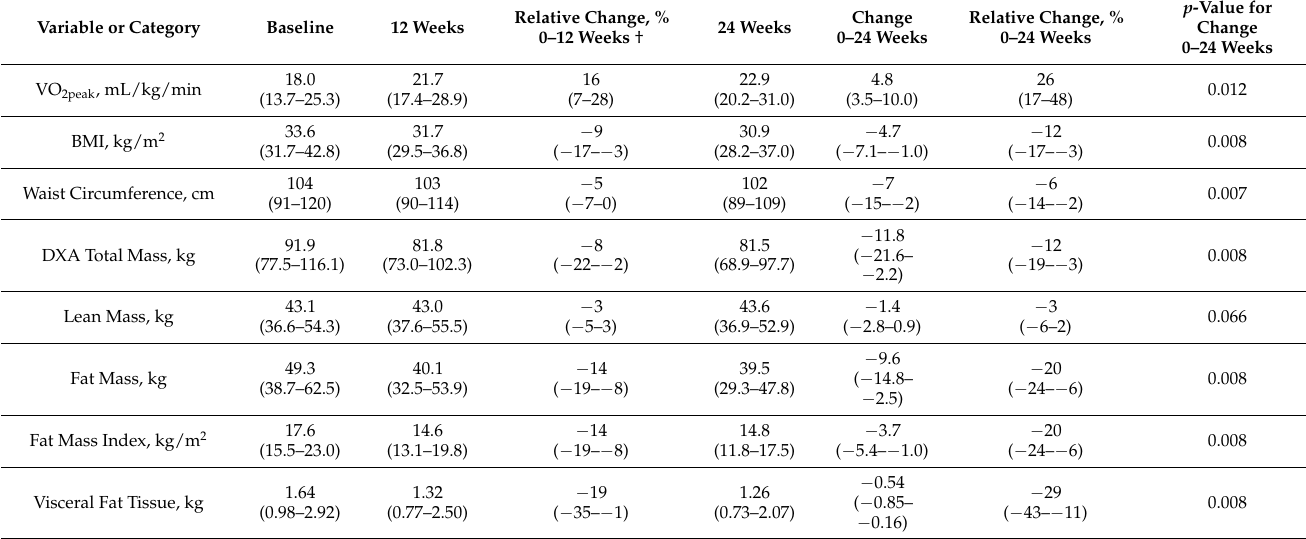
Table 4. Changes in VO 2peak , anthropomorphic, and body composition (DXA) parameters for 9 women complementing a 24-week weight-loss intervention with twice weekly personal trainers during initial 12 weeks only but provided continued access to exercise facility weeks 13–24. Median (range) values. p -values from Wilcoxon signed rank test, 2-tailed.